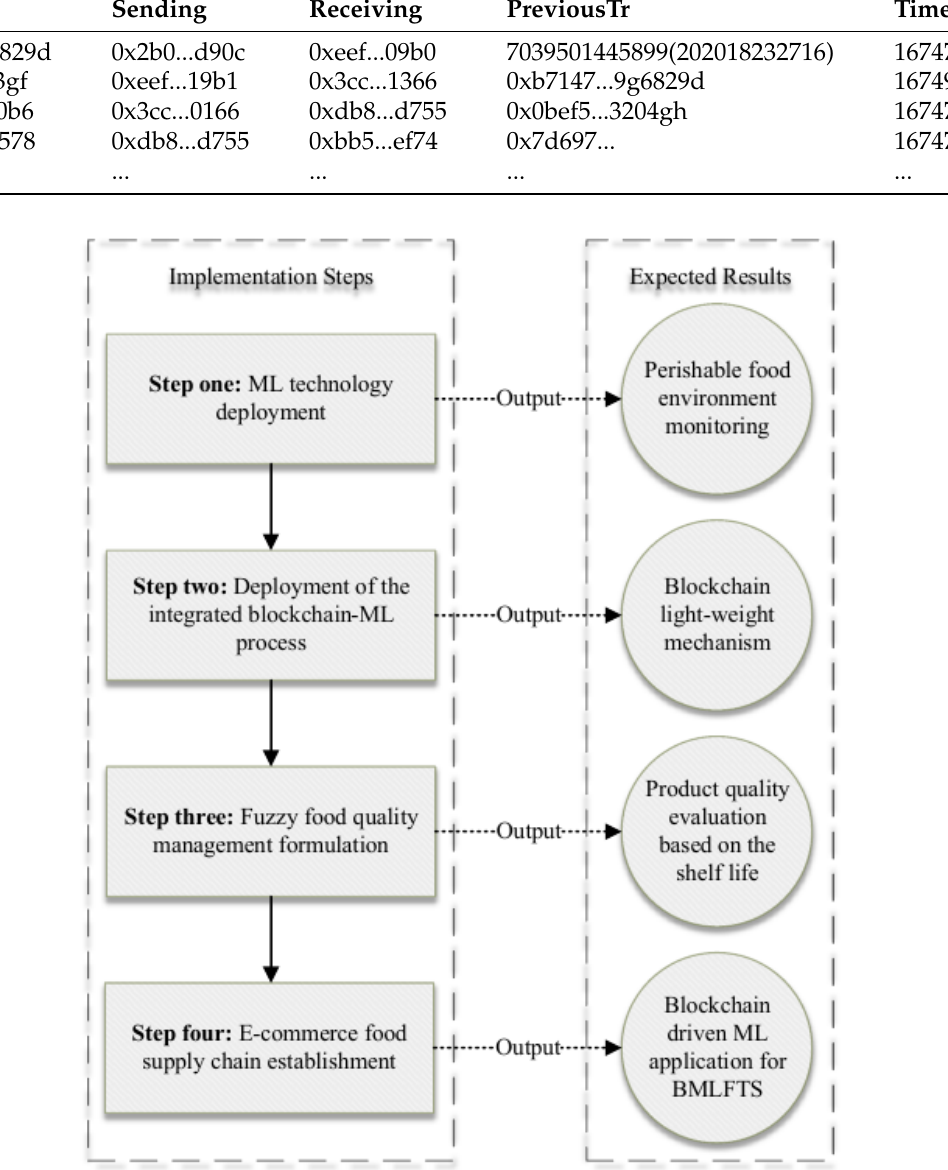
Figure 5. Implementation process of the BMLFTS in perishable food supply chain